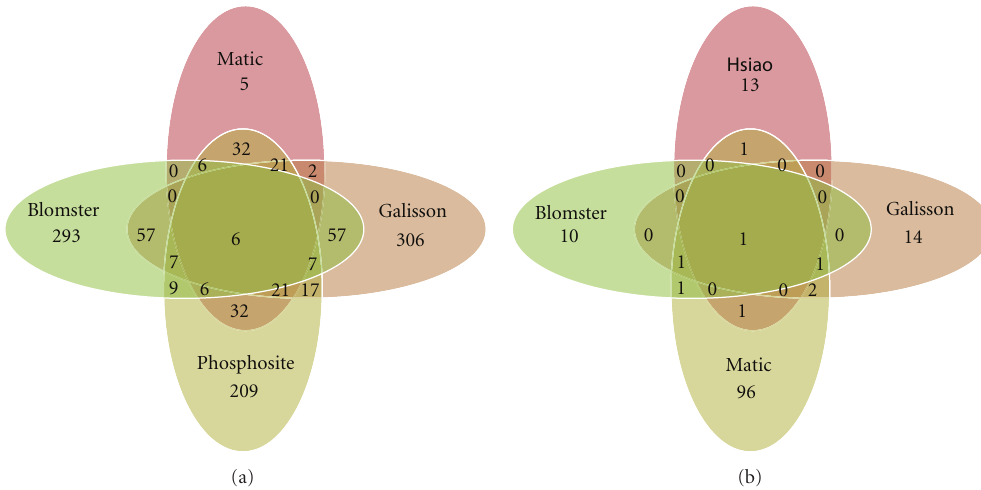
Figure 4: Comparative analysis of SUMO-modified proteins. (a) All proteins reported to be SUMOylated in the literature and at PhosphoSitePlus database (http://www.phosphosite.org/) were manually extracted and compared to those found by MS in 3 recent studies [39, 75, 76]. The protein list in the PhosphoSitePlus includes proteins for which the site of SUMO modification was not determined by MS. All protein names and accession numbers were first mapped to Uniprot accession numbers by using mapping data downloaded from ENSEMBL. Next, all Uniprot accession numbers were mapped to HGNC symbols and HGNC symbols for each study were uploaded to MySQL database. This means that all protein accessions that mapped to the same HGNC symbol were considered as redundant for the comparative analysis provided here. Finally, the necessary MySQL queries were made to define overlapping HGNC symbols between the di ff erent resources and the output used for creating the presented SUMO protein Venn diagram. List of proteins identified by other authors and confirmed by Matic et al.: PSMD12, TRIM24, CD3EAP, SART1, MYO1B, BRD4, SF3B1, LMNA, HNRNPC, PARP1, TOP1, KRT5, FOSL2, FLNA, MAP4, CANX, PML, STAT1, MKI67, RANGAP1, YLPM1, RBM25, RANBP2, VASP, HNRNPM, ADAR, ACTB, SUMO2, SUMO1, GTF2I, KHDRBS1, RLF, TRIM28, TCOF1, NAB1, SAFB2, NUMA1, IFI16, ZNF800, ARID4B, ZMYM1, ZMYM4, PTRF, PBRM1, CCAR1, RBM12B, FNBP4, ZBTB38, ZNF280C, KDM2B, GEMIN5, RREB1, SYMPK, ZBTB9, THOC1, ERBB2IP, RSF1, HNRNPUL1, PNN, BCLAF1, ACIN1, ZNF295, ZMYND8, TRIM33, ZBTB1, ZNF451, ACTG1, ACTB. Proteins considered in this analysis are included in the Supplementary Table 1. (b) Comparative analysis of SUMOylation sites. All peptide sequence reported with annotated SUMOylation sites based on mass spectrometry data from Matic et al . [39], Galisson et al . [76], Hsiao et al . [77], and Blomster et al . [78] were manually extracted. For each SUMO-modified site, six flanking amino acid residues on both sides were extracted. The resulting 13 amino acid residue sequences from each of the above mentioned studies were uploaded to an MySQL database and the necessary queries for comparing the peptides between studies were performed and used as input for the creation of the SUMO peptide Venn